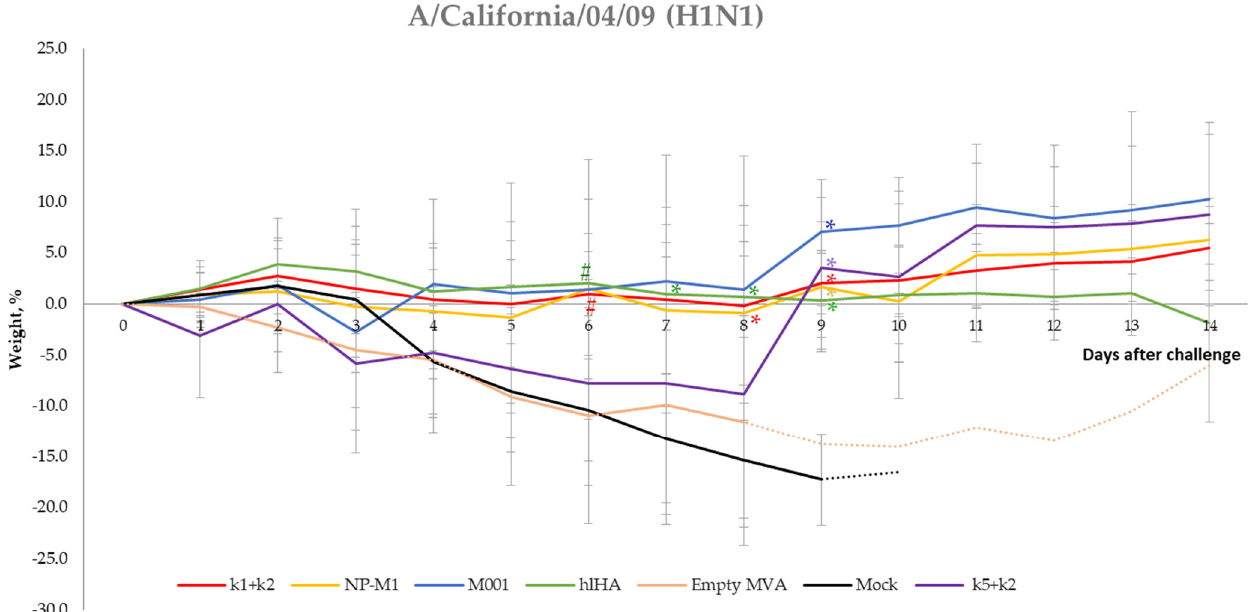
Figure A1. Loss of body weight of mice immunized with rMVAs expressing influenza virus antigens, or with wt MVA, or PBS after virus challenge with the H1N1 subtype virus strain A/California/04/09. The dotted line indicates that there are less than four mice. Significance codes ( p -value < 0.05): * compared to Mock group, # compared to Empty MVA group.